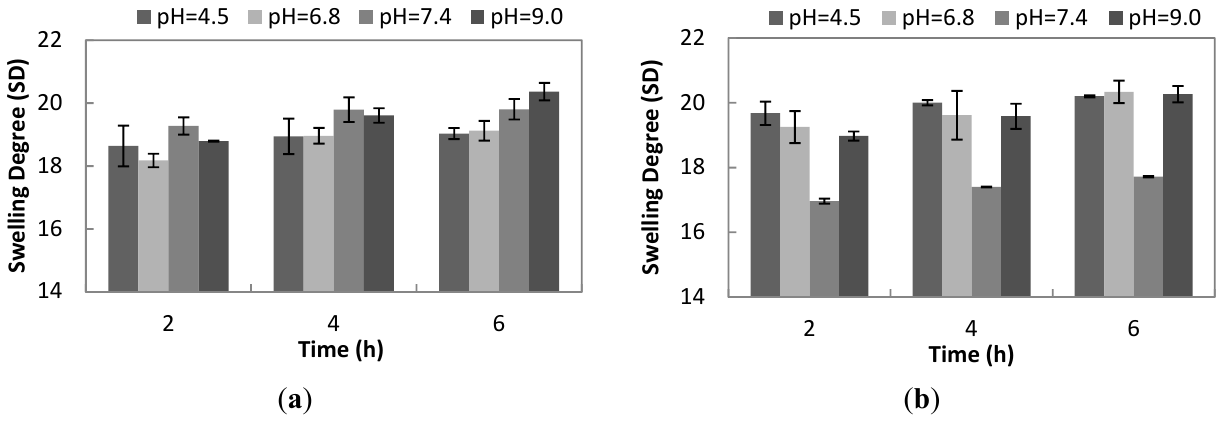
Figure 8. ( a ) Swelling kinetics of uncrosslinked hydrogel (10 w/v% gelatin and 1 w/v% γ -PGA) at different pH values for two, four and 6 h. ( b ) Swelling kinetics of optimized formulation of crosslinked hydrogel (10 w/v% gelatin, 1 w/v% γ -PGA and 1.3 mg/mL EDC) at different pH values for two, four and 6